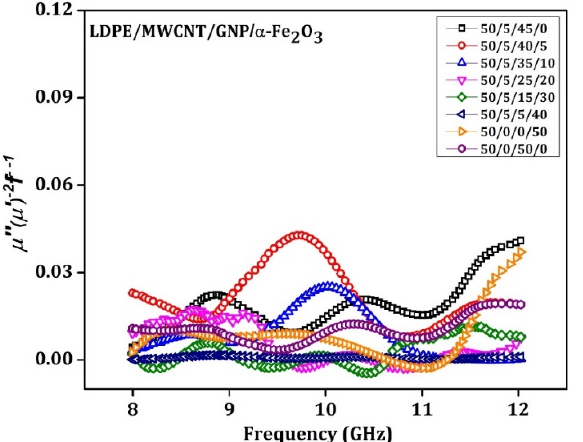
Figure 13. μ ” ( μ ’) − 2 f − 1 as a function of frequency for the 3.5 mm thick LDPE: MWCNT: GNP: α‐ Fe 2 O 3 matrix specimen.